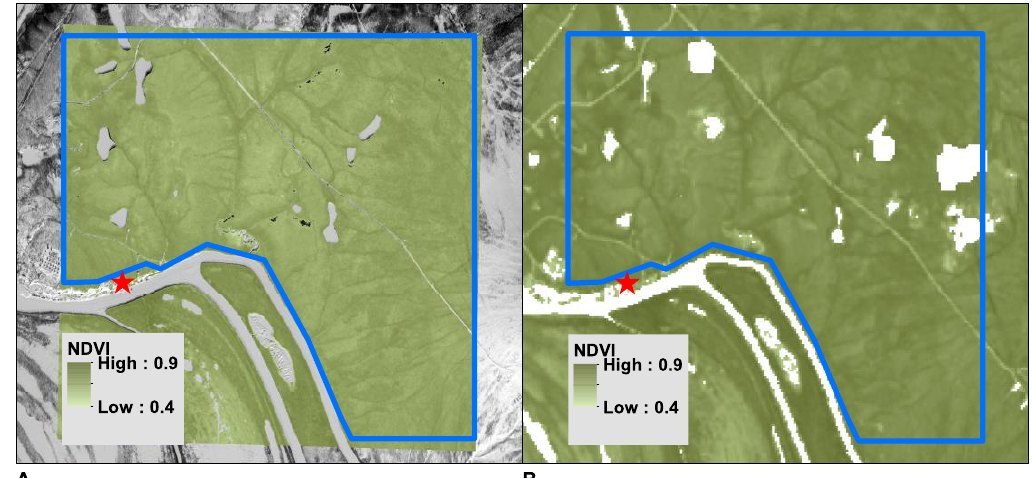
Figure 9. NDVI maps across the study area from PlanetScope on 26 July 2017 ( A ) and Landsat on 28 July 2017 ( B ). Note the maps use the same scale, indicating that Landsat has higher NDVI values than PlanetScope.